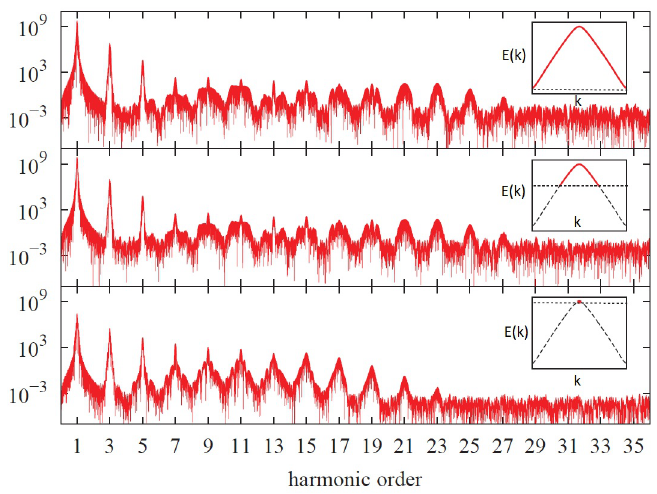
Figure 9. Contributions of different parts of the valence band (represented by red color above the dotted vertical lines in the insets) to the HHG spectra as calculated using the potential U ( a ) . Parameters: F 0 = 0.5GV / m (0.33 × 10 11 W / cm 2 peak intensity) λ L = 3 µ m and τ = 300fs. Note that the physical, measurable spectrum is the topmost one, where all initial states from the VB of the first Brillouin zone contribute to the radiation.